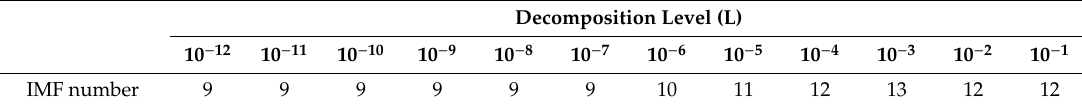
Table 2. Decomposition number of the IMF under each decomposition level.